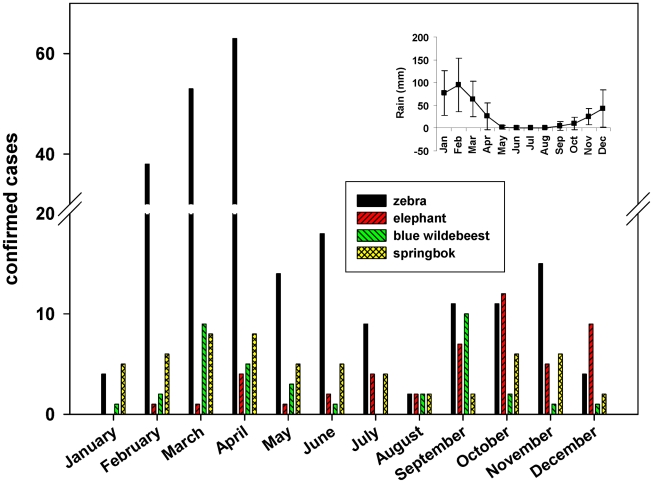
Confirmed cases of anthrax in the four most commonly affected species in the ENP.The period between 1988–2010 is shown. Isolates prior to 1988 have been excluded from this figure, having been collected during only short field studies in the Park. The insert indicates the mean monthly rain fall (in l/m2) in the Okaukuejo region, in 1983–2010.